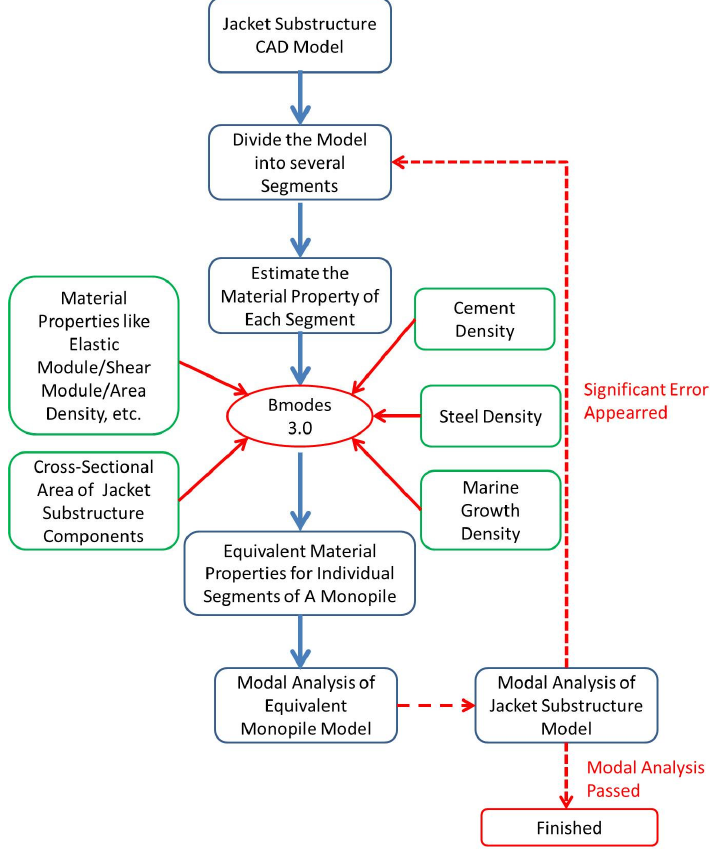
Figure 7. Flowchart of the Construction of Equivalent Monopile Model for Jacket Substructure.